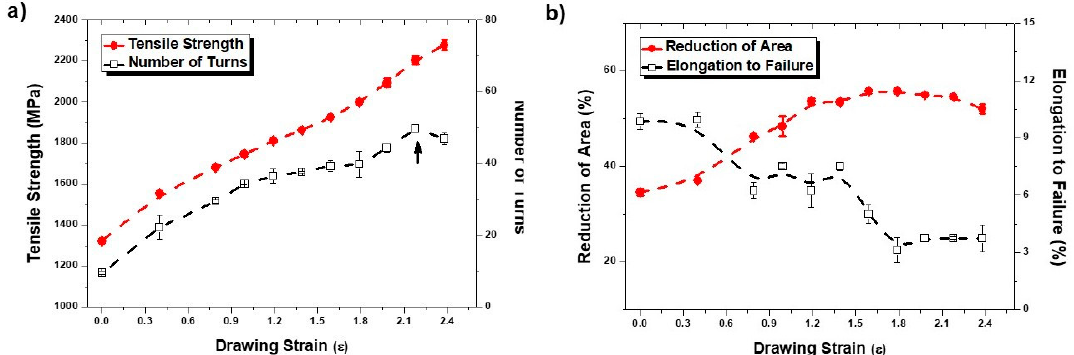
Figure 2. The variations of ( a ) TS and NT and ( b ) RA and EL with drawing strain in hyper-eutectoid steel wires.